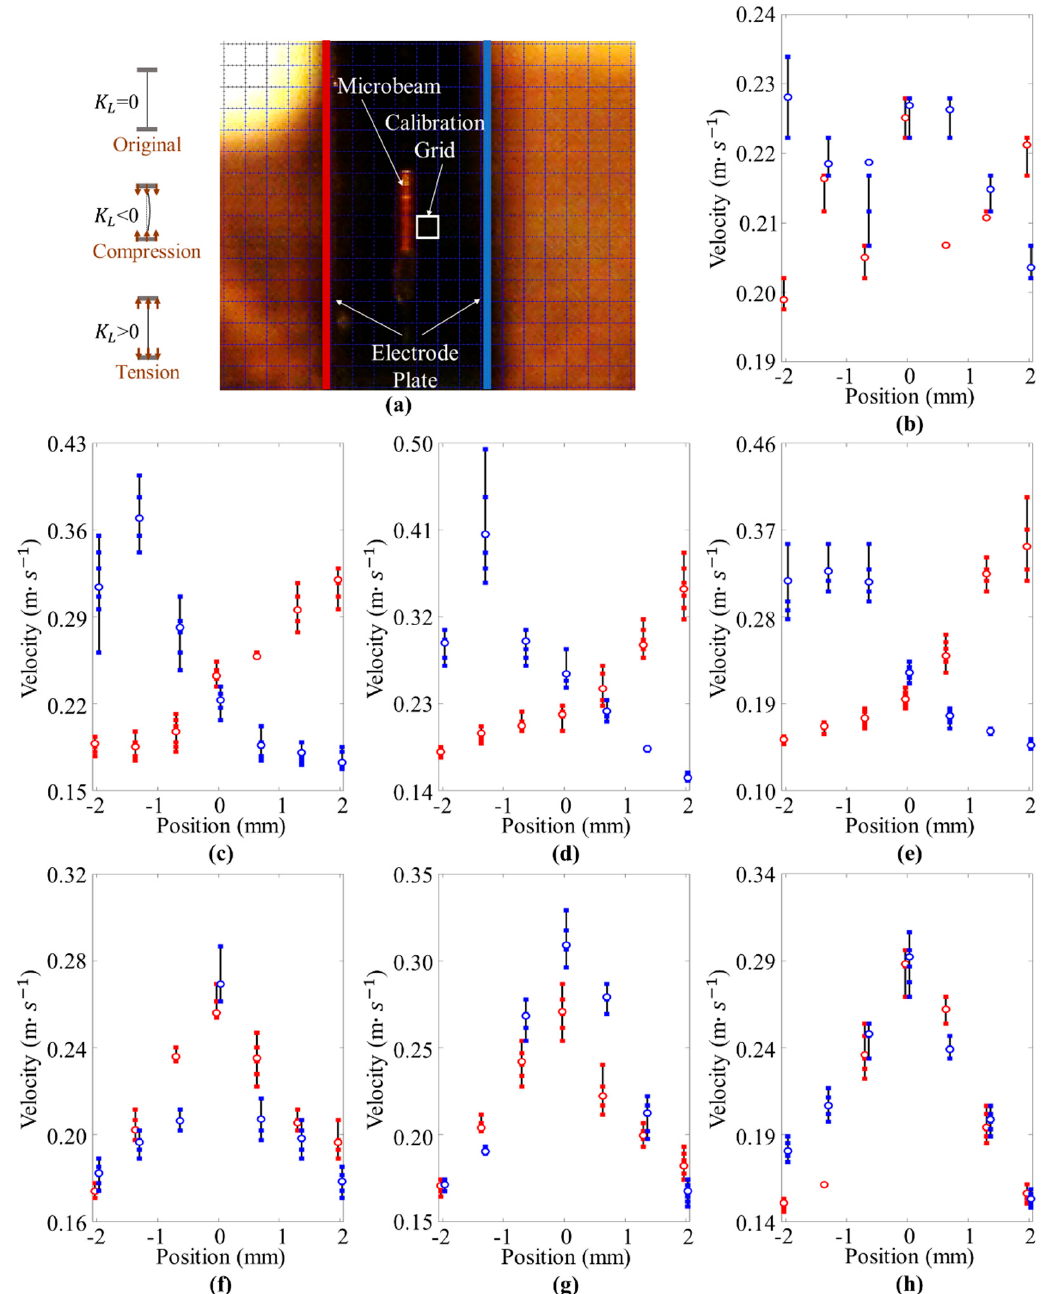
Figure 6. Experimental data of variable velocity-position characteristics under different constraint conditions: ( a ) snapshots of high-speed video; ( b ) the results under original constraint; ( c – e ) scatter-plot representation of the results under pre-compressed constraint, where ( c ) K L is − 1 mm, ( d ) K L is − 3 mm, and ( e ) K L is − 5 mm; ( f – h ) scatter-plot representation of the results under pre-compressed constraint, where ( f ) K L is 1 mm, ( g ) K L is 3 mm, and ( h ) K L is 5 mm. The red points represent the result in the first half cycle, and the blue points represent the result in the second half cycle.